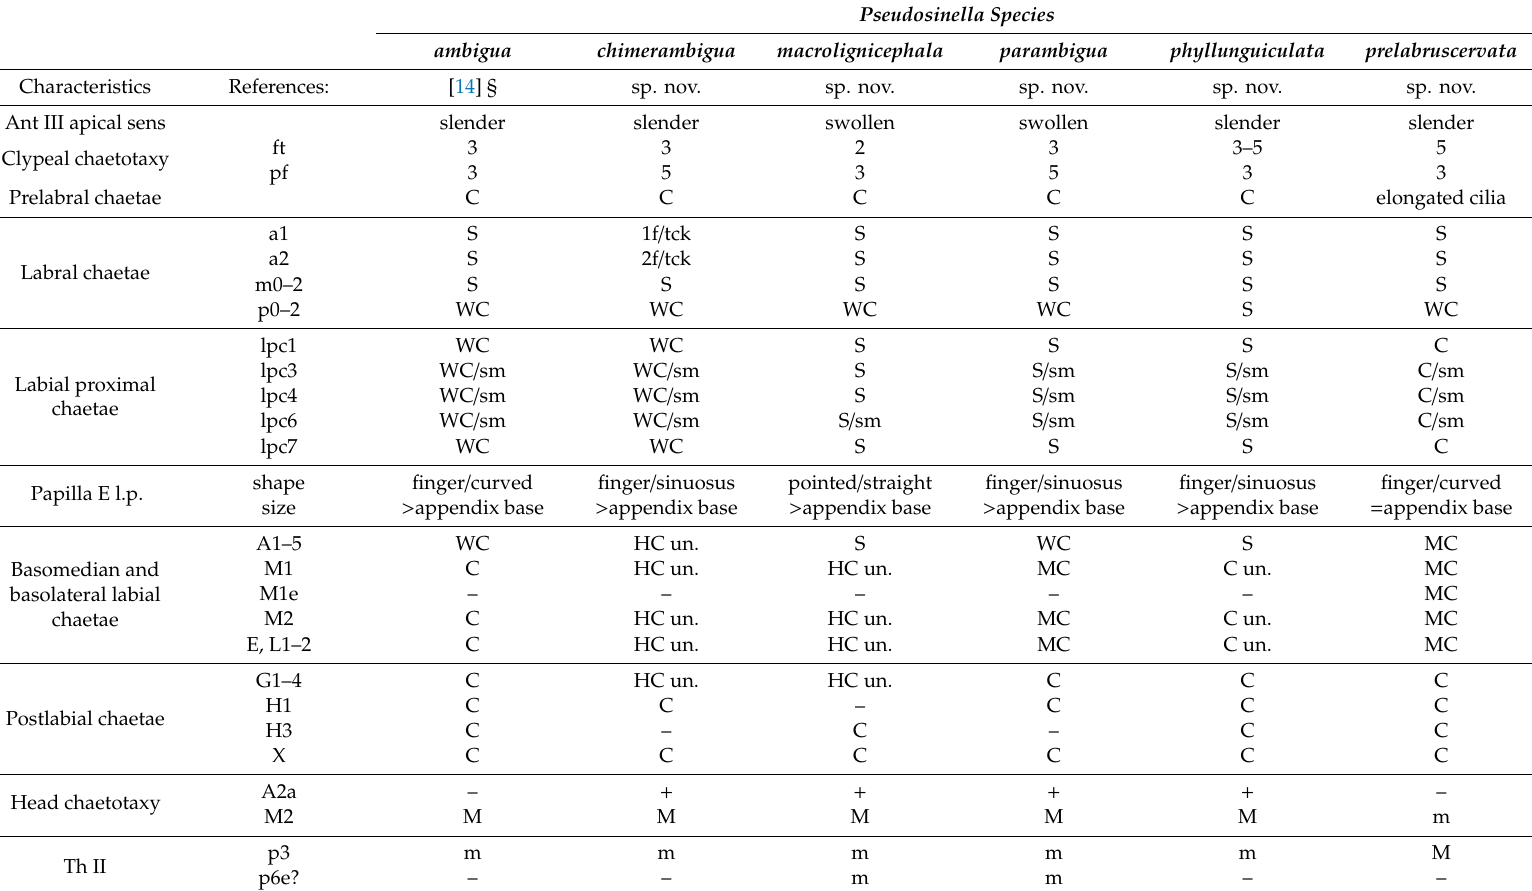
Table 6. Comparison (per side) among Pseudosinella species from Minas Gerais (Brazil) with prelabral chaetae bifurcate, maxillary palp b.c. weakly ciliate, Th III devoid mac, unguiculus pe lamella of toothless, basomedian labial field with r chaeta reduced, Abd II with m3 and m5 mac, Abd IV with 3 central mac (B5–6 and C1), tibiotarsal modified chaetae type III, furcula only with ciliate chaetae, devoid of pigments, eyes and apical bulb on Ant